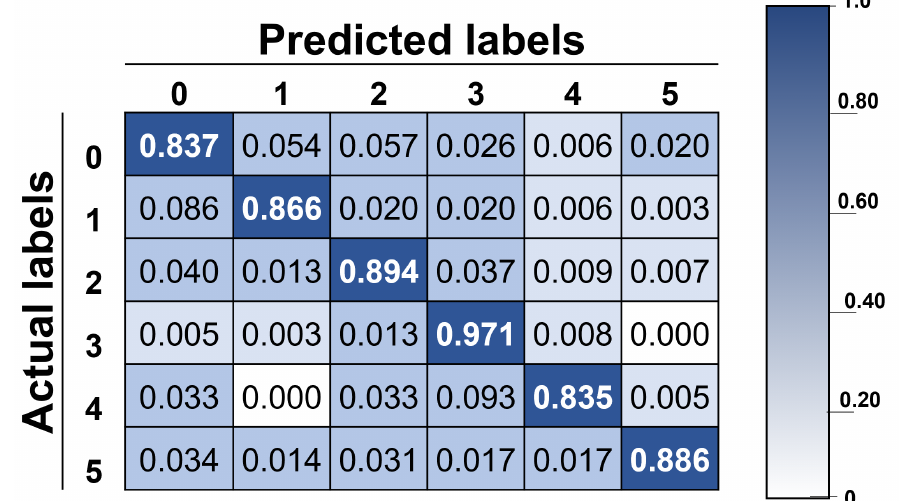
Figure 5. Confusion matrix with actual and predicted labels: class 0 for neutral face, class 1 for eyebrow elevation, class 2 for eye closure, class 3 for wide-open smile, class 4 for closed mouth smile, and class 5 for